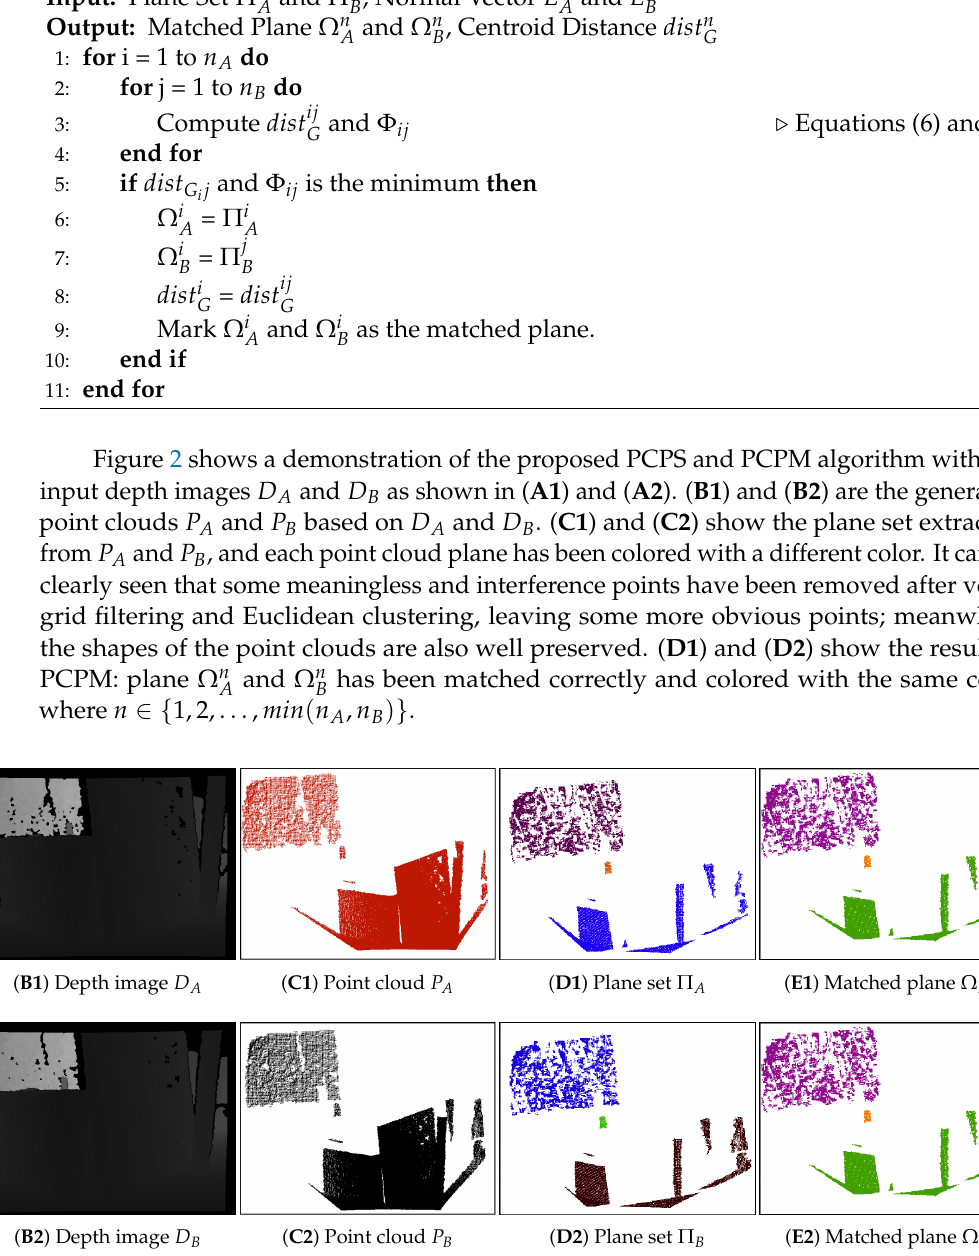
Figure 2. Demonstration of the result of the PCPS and PCPM: ( A1 , A2 ) the input RGB images I A and I B ; ( B1 , B2 ) the input depth images D A and D B ; ( C1 , C2 ) the generated point clouds P A and P B based on D A and D B ; ( D1 , D2 ) the obtained plane set S A and S B after PCPS; ( E1 , E2 ) matched planes Ω A and Ω B obtained by